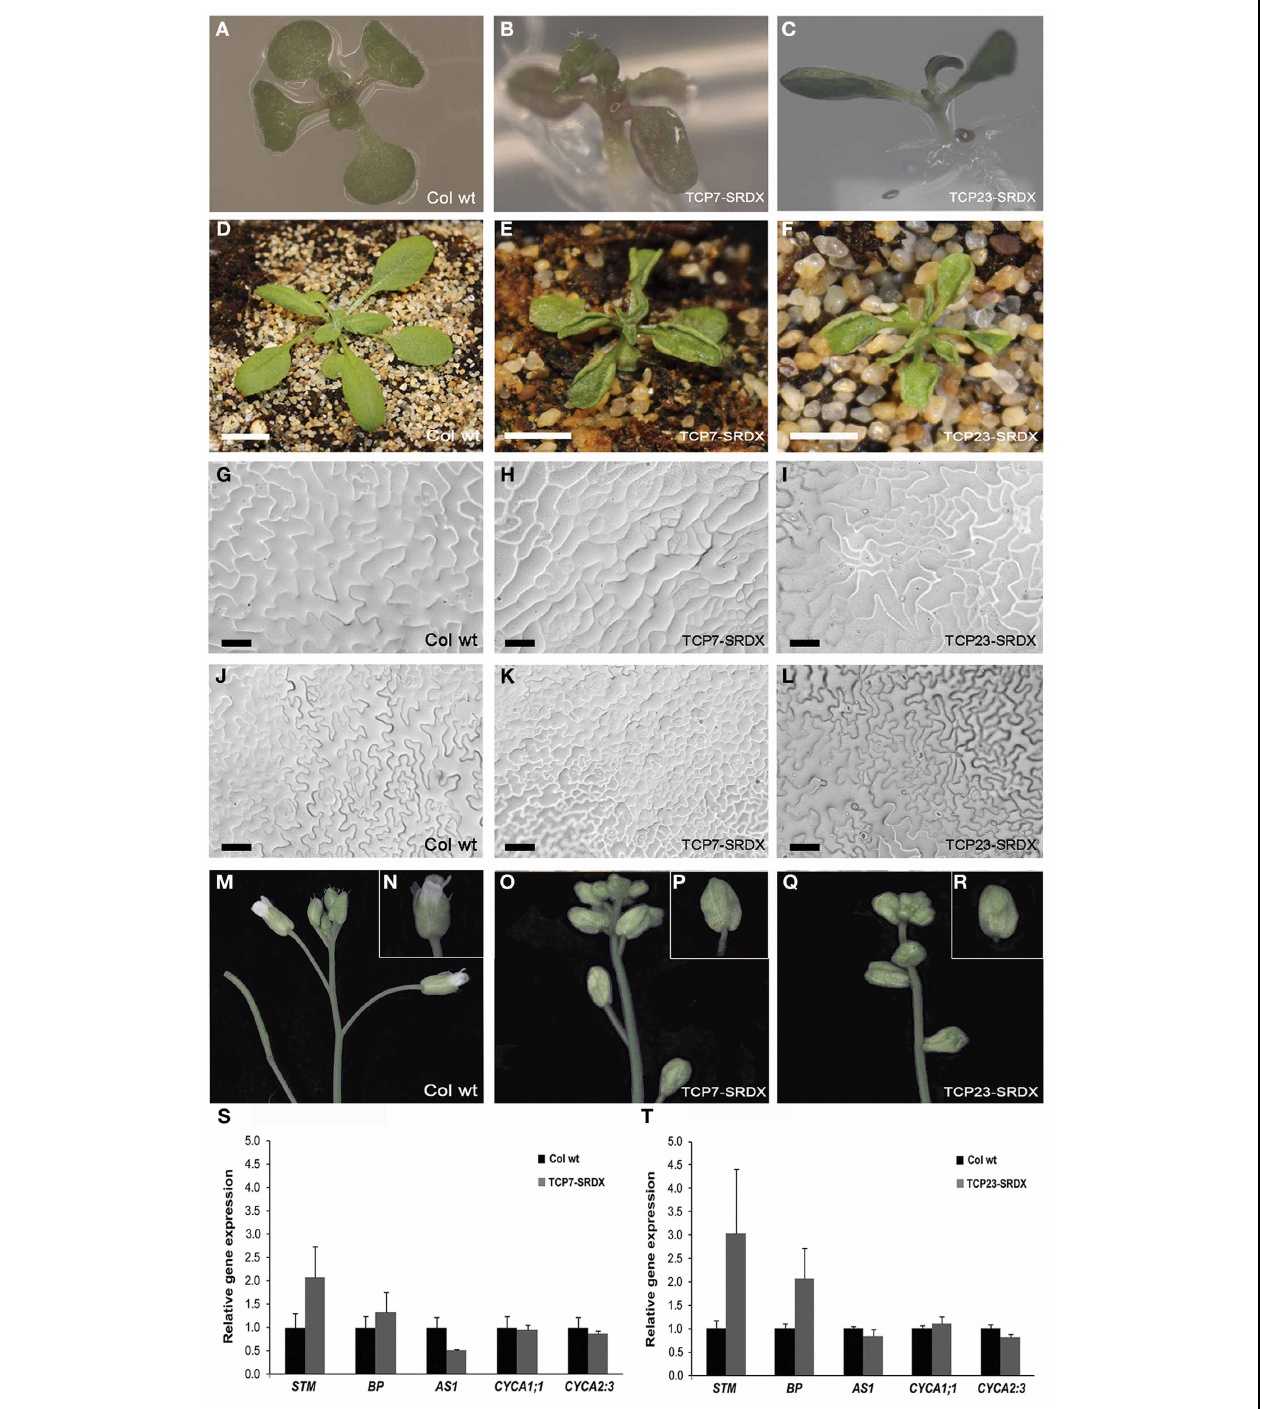
FIGURE 6 | Characterization of transgenic plants harboring class I TCP genes At TCP7 and At TCP23 fused to the repressor domain SRDX. (A–C) Phenotype of 10 days-old seedlings of TCP7-SRDX and TCP23-SRDX transgenic lines. (A) Col wt. (B) TCP7-SRDX. (C) TCP23-SRDX. (D) Plants at bolting stage of Col wt; (E) of TCP7-SRDX and (F) of TCP23-SRDX. (G–L) Leaf epidermis nail polish impressions in Col wt (G,J) , TCP7-SRDX (H,K) and TCP23-SRDX (I,L) plants. (G–I)